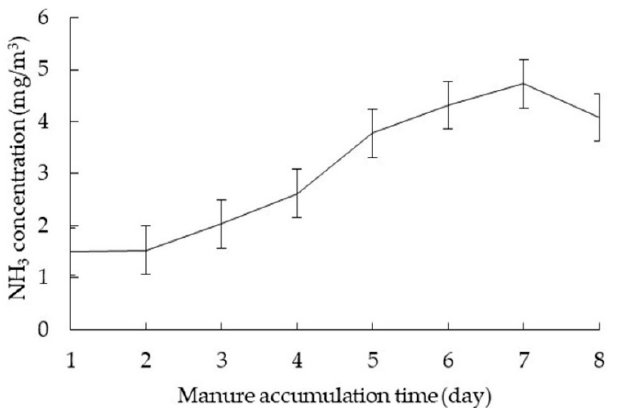
Figure 5. NH 3 concentration in NM with the manure accumulation time extending.